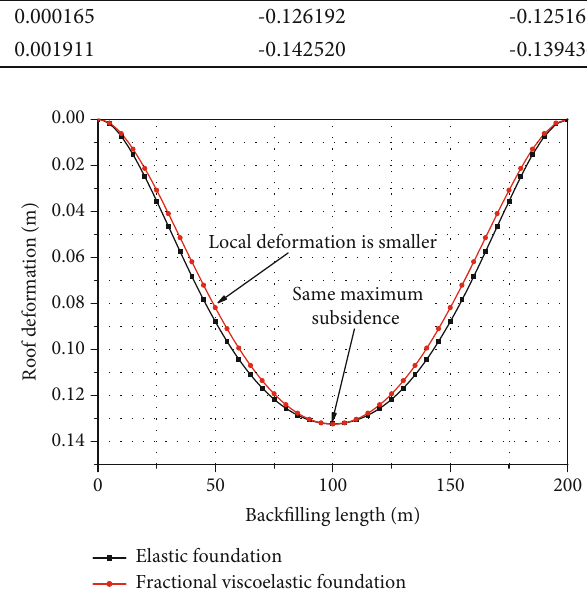
Figure 7: Roof subsidence of elastic foundation and fractional foundation.